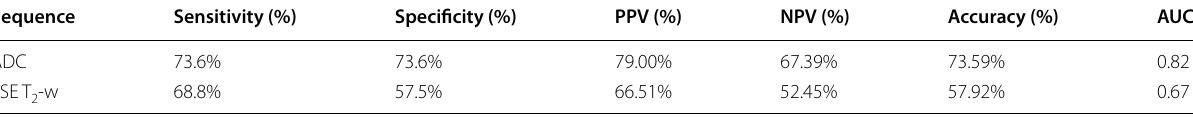
Table 2 Diagnostic capability of ADC and FSE T2‑w in osteoporotic vertebrae